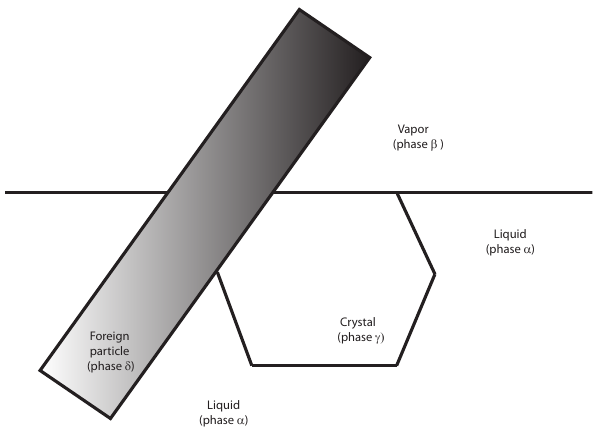
Fig. 4. Mechanism of contact freezing based on the different phases interactions (Djikaev and Ruckenstein,